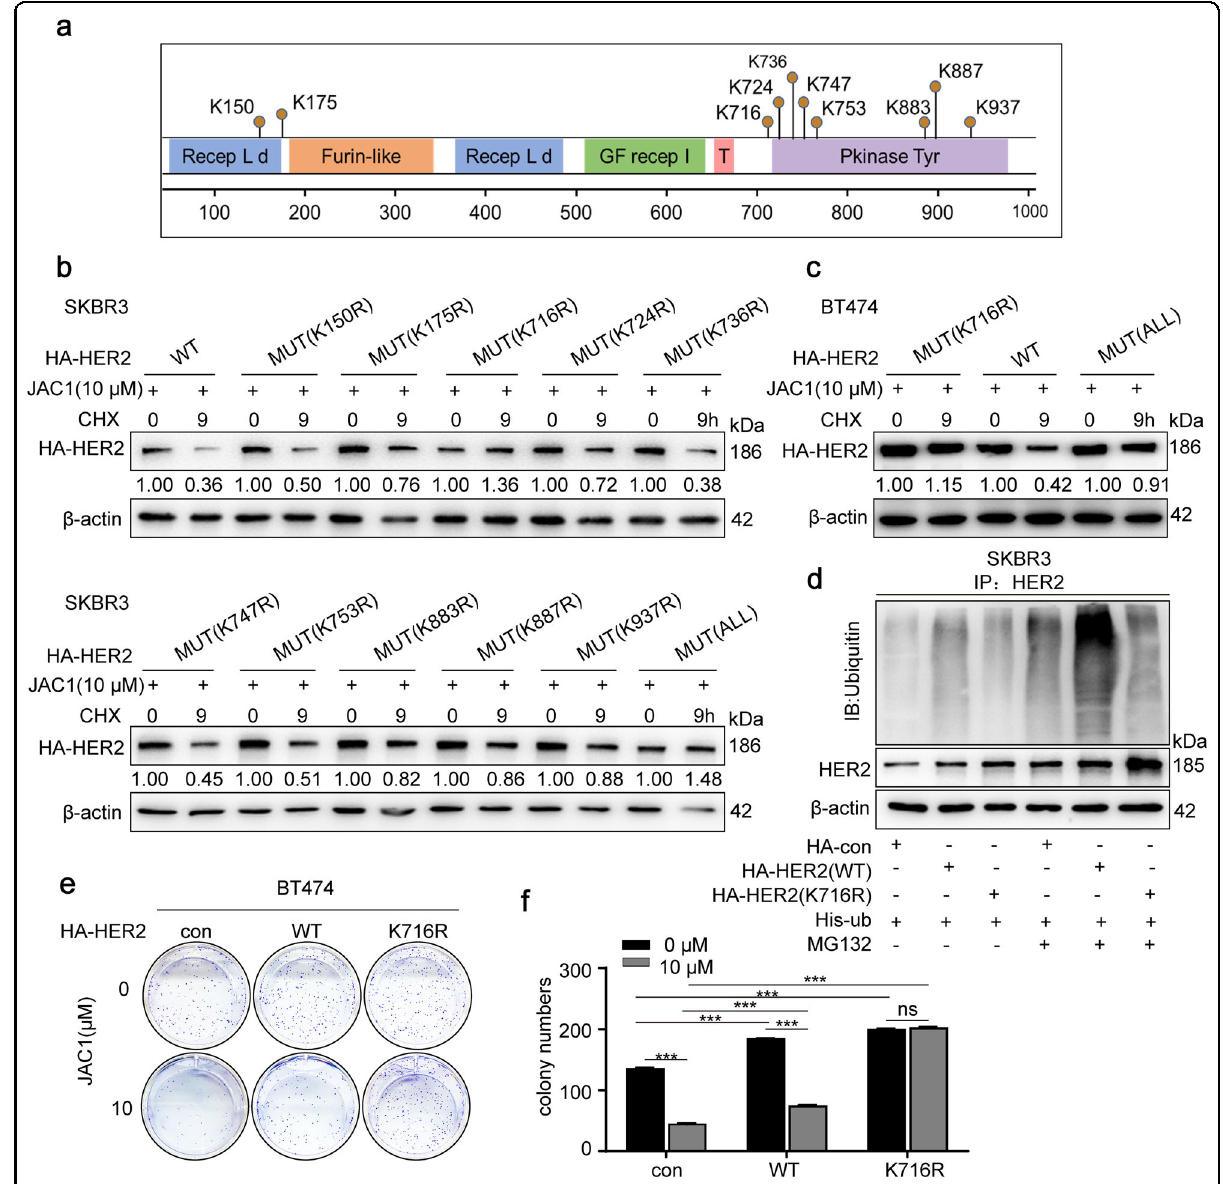
Fig. 4 K716 of HER2 is the ubiquitination target by SMURF1. a Data from the PhosphoSitePlus (https://www.phosphosite.org) showed the potential sites required for ubiquitination of HER2. b SKBR3 cells were transfected with His-HER2 (WT) or 11 mutants (10 separate single amino acid mutants and all 10 mutated amino acids in HER2), treated with the 10 μ M JAC1 for 24 h, followed by exposure to CHX (100 μ g/mL) for 9 h. Protein expression of HER2 was detected by western blot. c BT474 cells were transfected with HA-HER2 (WT), HA-HER2 (K716) or HA-HER2 (ALL) for 72 h, treated with the 10 μ M JAC1 for 24 h, followed by exposure to 100 μ g/mL of CHX for 9 h; the protein expression of HER2 was determined by western blot. d SKBR3 cells were co-transfected with His-Ub, HA-HER2 (WT), or HA-HER2 (K716) for 72 h, followed by pretreatment with MG132 (10 μ M) for 6 h. Ubiquitinated HA-HER2 was determined by IP followed immunoblot. e Colony formation assay was completed for WT/K716R HER2 transfected BT474 cells and followed by JAC1 (10 μ M) treatment. f The quantitative data of colony